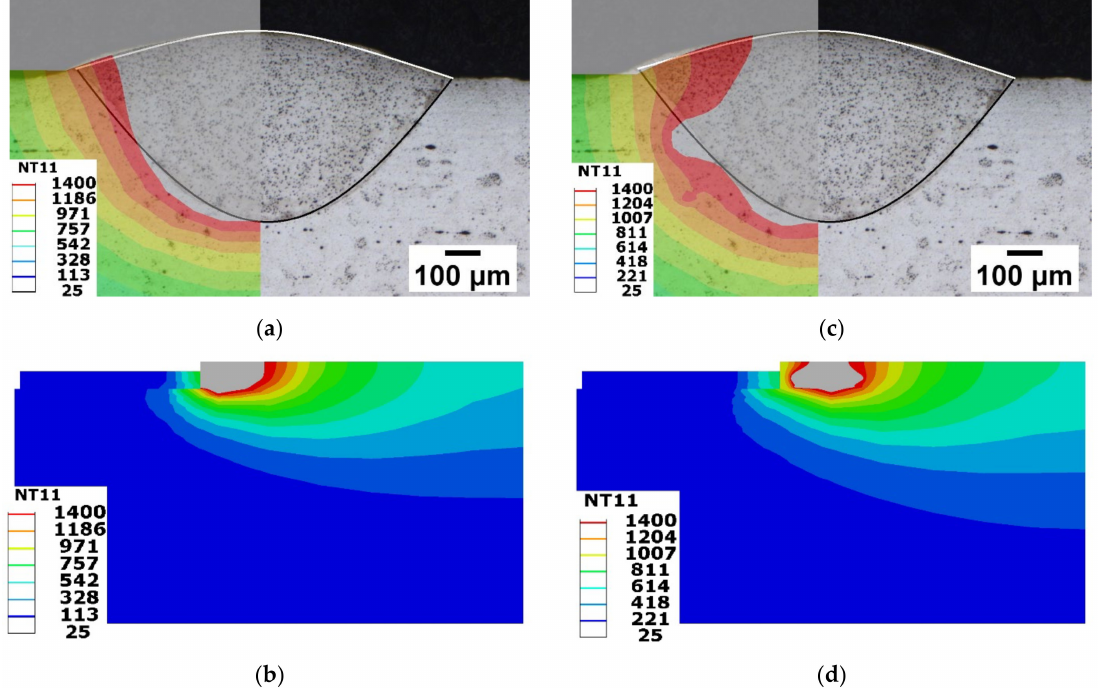
Figure 14. Comparison of the melt pool size between simulation and experiment: Transverse section view ( a ) Concentric heat model; ( c ) Goldak model. Longitudinal cut section view ( b ) Concentric heat model; ( d ) Goldak